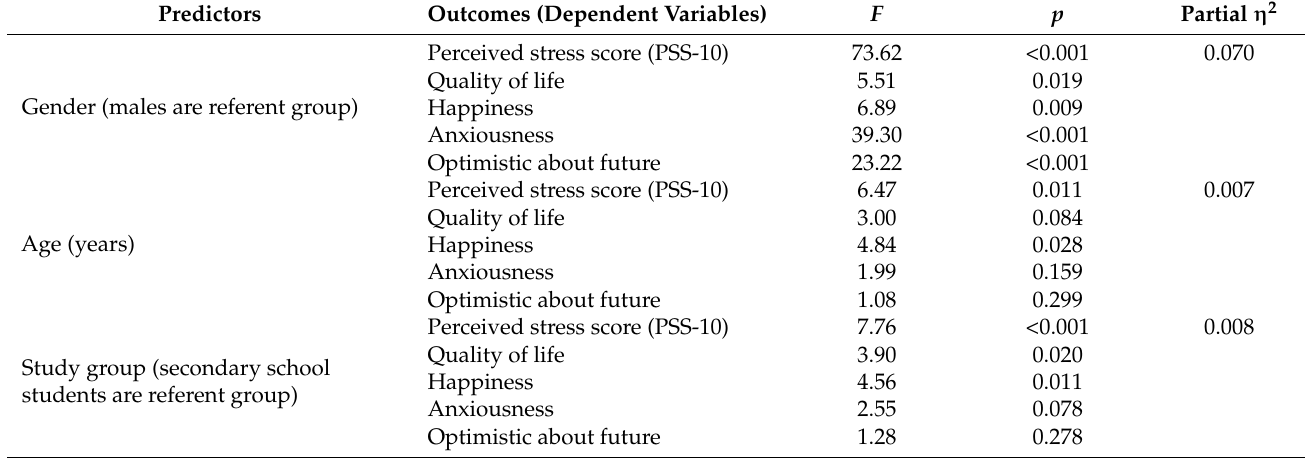
Table 4. Association of the Mediterranean diet, sleep duration, sedentary activity, and COVID-19 lockdown with psy- chological well-being in students, using multivariate general linear model (all psychological well-being variables were simultaneously entered as dependent